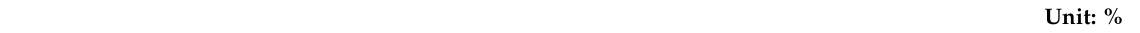
Table 1. Chemical properties of fly ash produced and ground granulated blast-furnace slag (GGBFs) in this